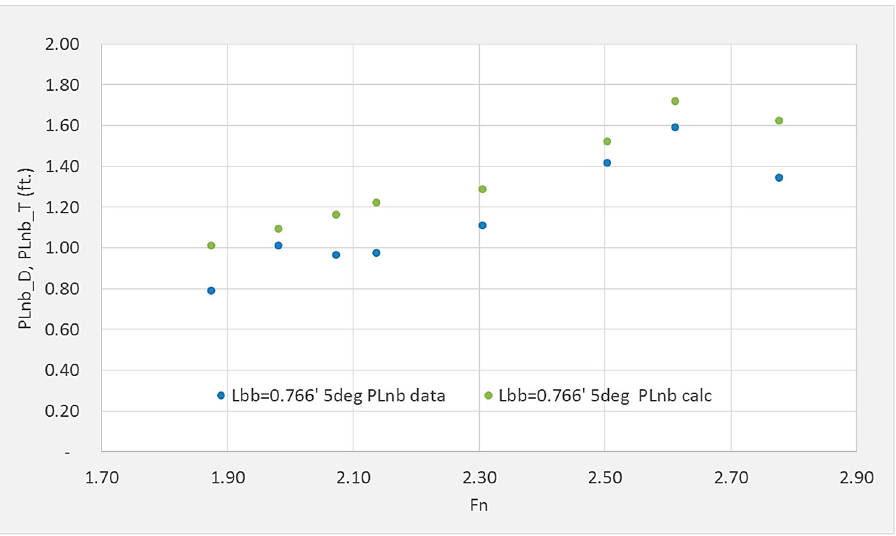
Figure 15. PL bb _ data and PL bb _ calc for bulbs with 5° pitch angle.